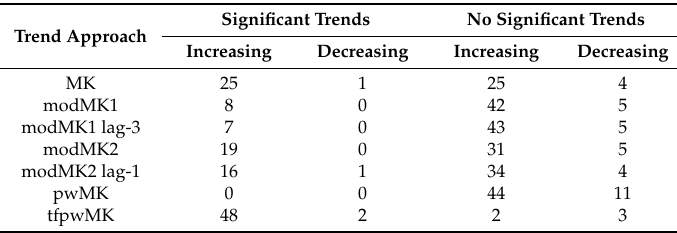
Figure 10. Changing spatial trends of drought severity based on the SPI-12 detected by the ( a ) regular MK test (without removal of serial correlation), ( b ) the modified MK (modMK1) test and ( c ) modified MK test by considering first three lags (modMK1 lag-3) only, ( d ) the modified MK test (modMK2) and ( e ) modified MK test considering first lag (modMK2 lag-1) only, ( f ) pre-whitened MK (pwMK) test and ( g ) trend-free pre-whitening MK (tfpwMK) test. The number of gauges showing significant trends above the field significance are highlighted in red. Table 3. Summary of the number of stations with significant and non-significant trends detected by different trend tests for SPI-12 time series across South